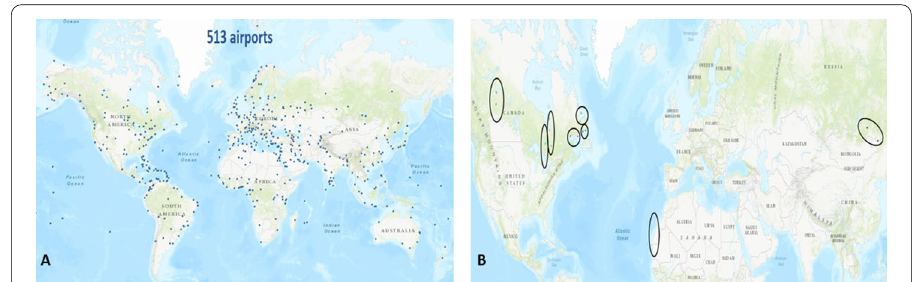
Fig. 12 a The airports in the large global component. b The 8 small global components which are circled. The size range are between 2 and 3